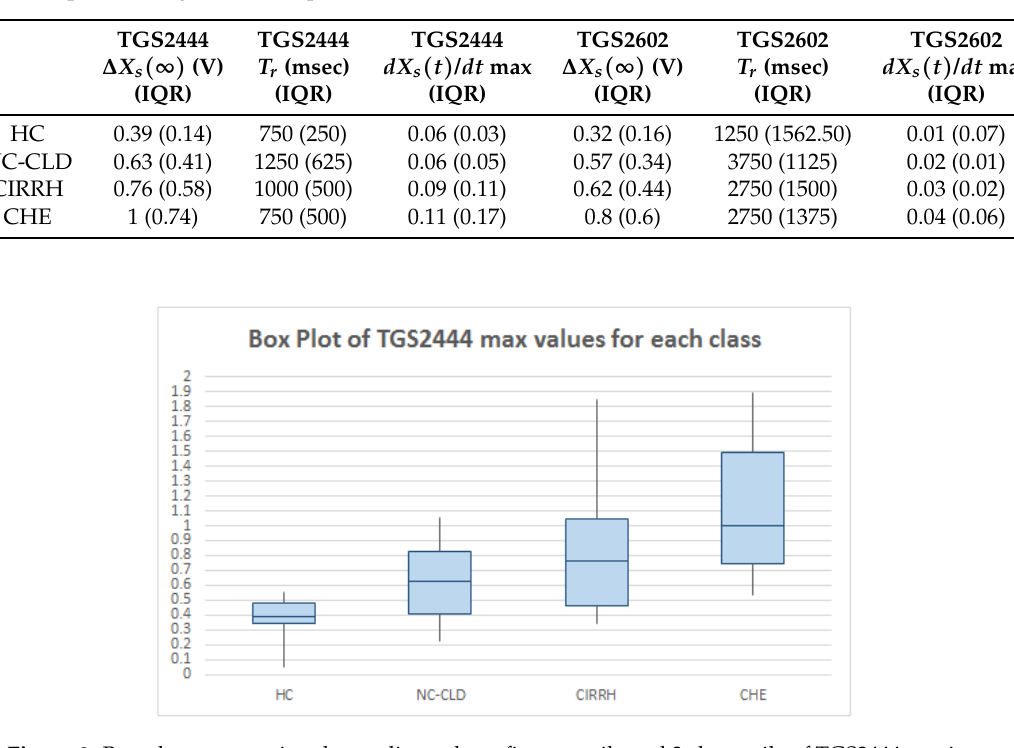
Figure 2. Box plot representing the median values, first quartile and 3rd quartile of TGS2444 maximum outputs relative to healthy controls (HC), non cirrhotic-chronic liver disease (NC-CLD), cirrhotics (CIRRH) and cirrhotics with a recent episode of Hepathic Hencephalopathy (CHE).